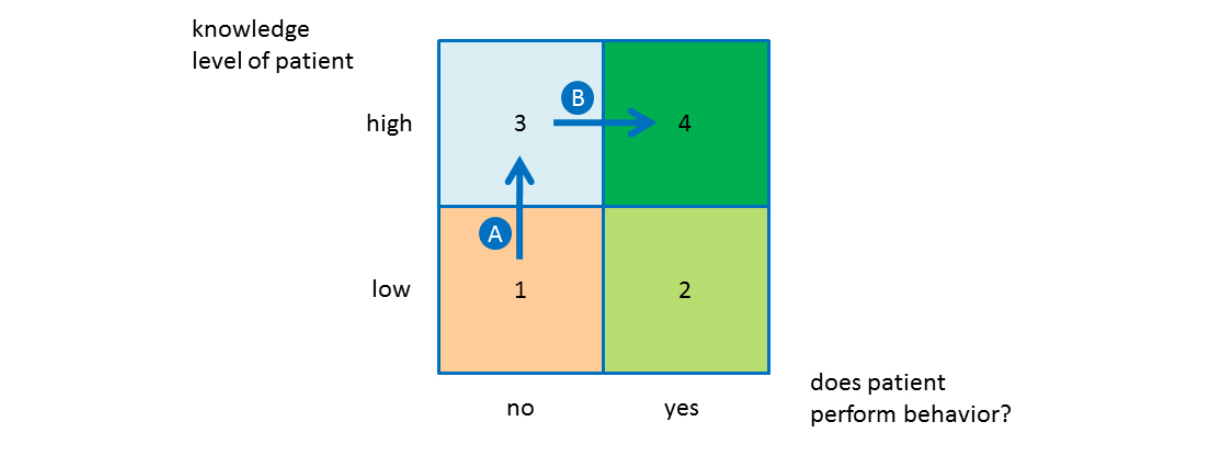
Figure 1. The education and coaching framework. Arrow A denotes education, and arrow B denotes